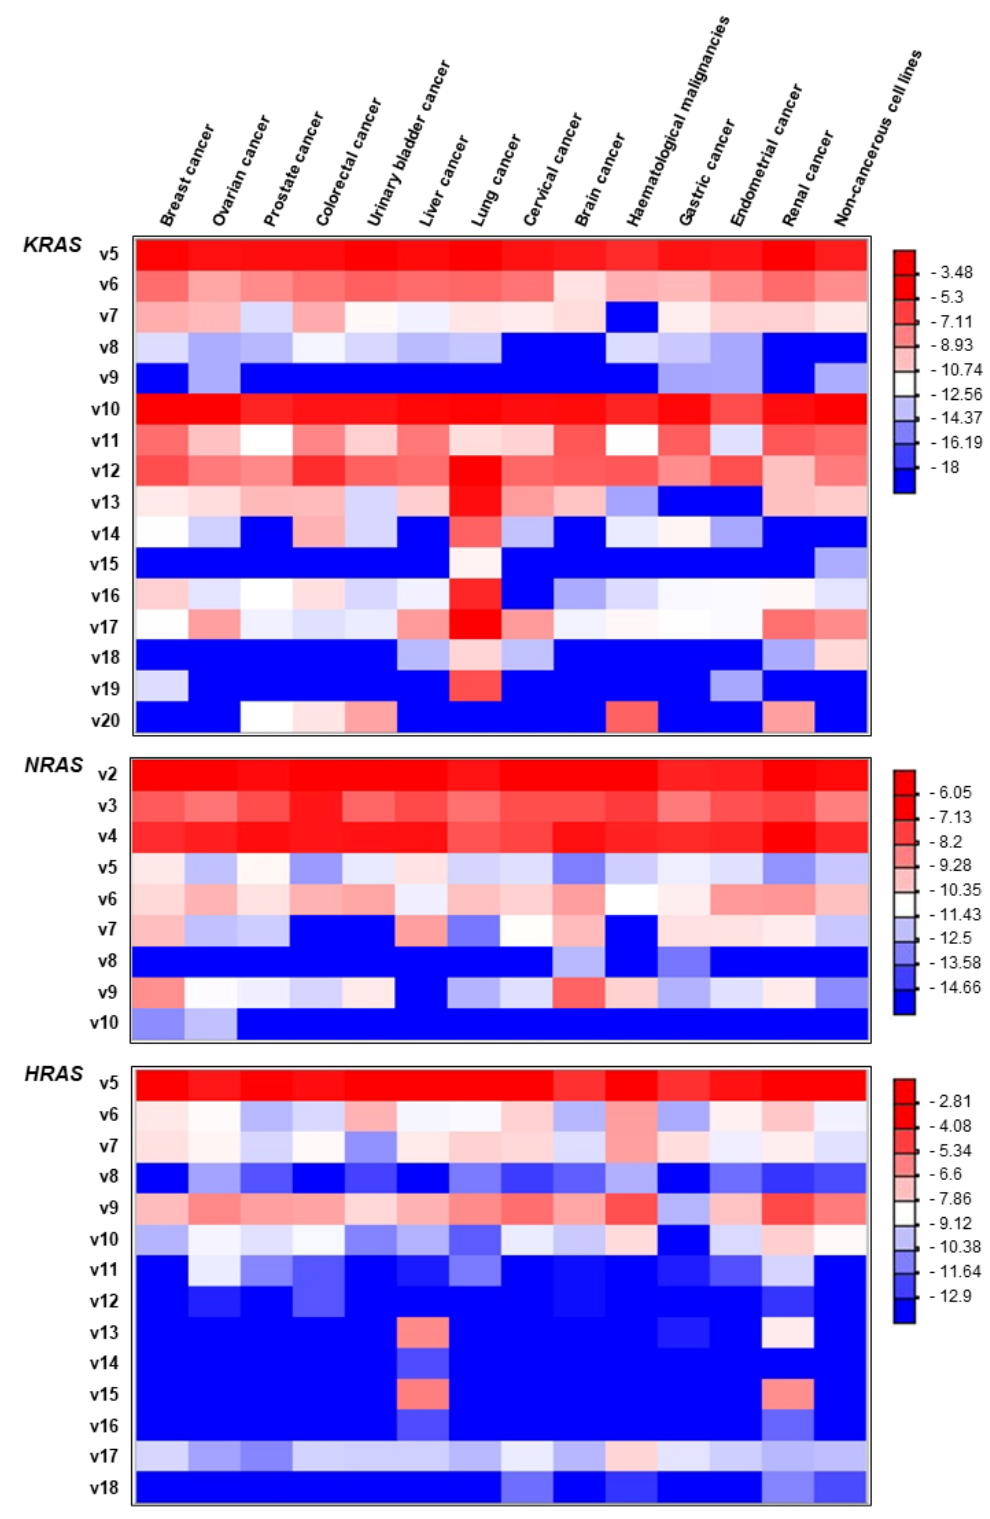
Figure 5. Heatmap demonstrating the fold change (Log2FC) ratios of each novel transcript variant relative to the abundance of the annotated mRNA(s) for each RAS gene. Negative values in the color scale bar indicate that all the novel alternative transcript variants are downregulated compared to the main transcript variant. Red coloring is indicative of higher relative abundance of the corresponding transcript variant, whereas blue coloring corresponds to low-frequent or undetectable transcript variants.